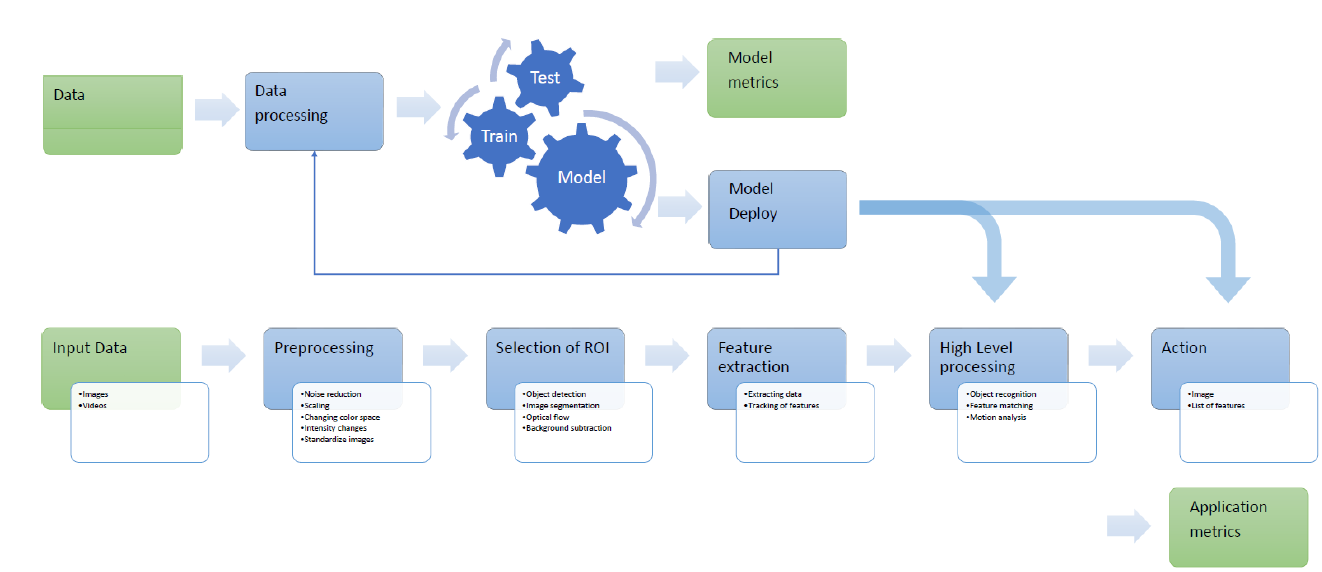
Figure 3. Framework of a modern CV